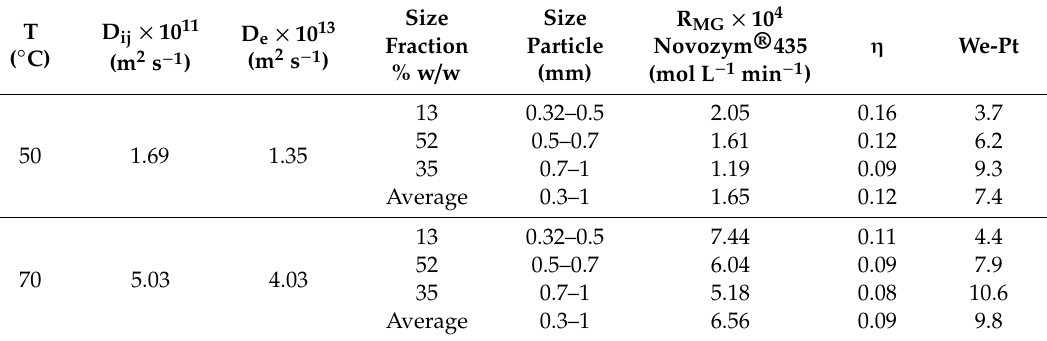
Table 1. Values of the e ff ective di ff usion coe ffi cient, e ff ectiveness factor, and Weisz–Prater criterion at 50 and 70 ◦